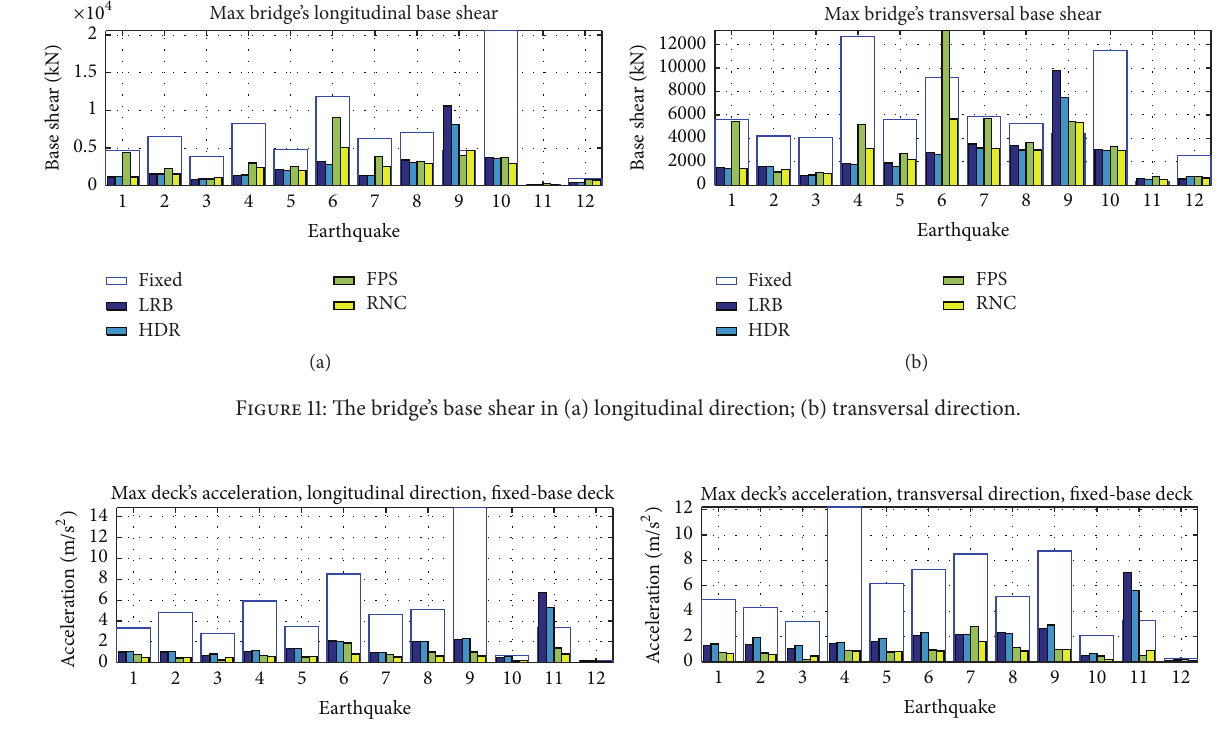
Figure 12: The deck’s peak accelerations: (a) in longitudinal direction; (b) in transversal